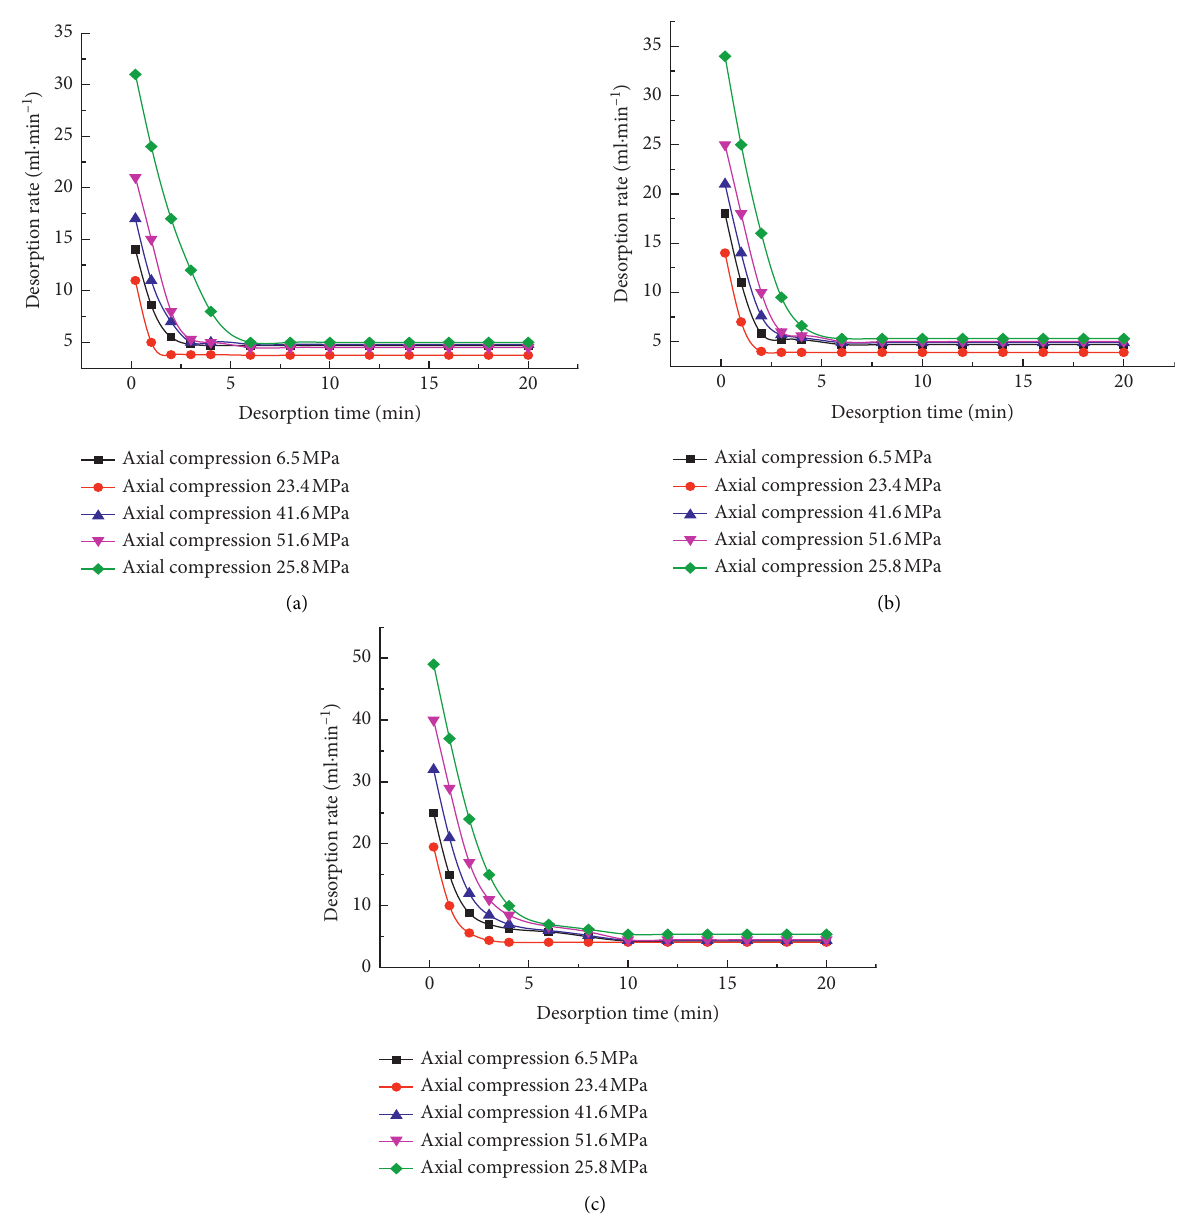
Figure 14: Desorption rate curve under the confining pressure of 5MPa at the temperature of (a) 30 ° C, (b) 45 ° C, and (c) 60 °